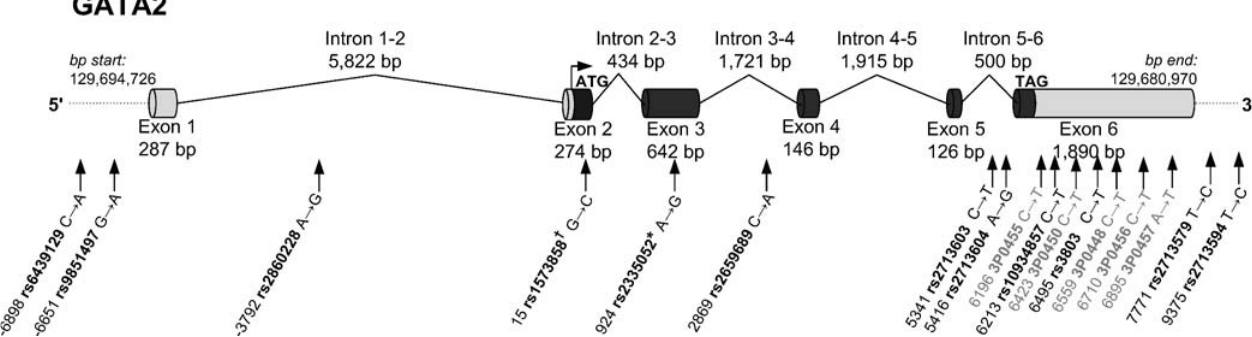
Figure 1. Schematic of the GATA2 Gene Structure The 12 SNPs representing predicted LD bins in GATA2 are shown in black; the five novel SNPs identified through sequencing are shown in grey. (cid:1) and * indicate a synonymous and nonsynonymous SNP, respectively. DOI: